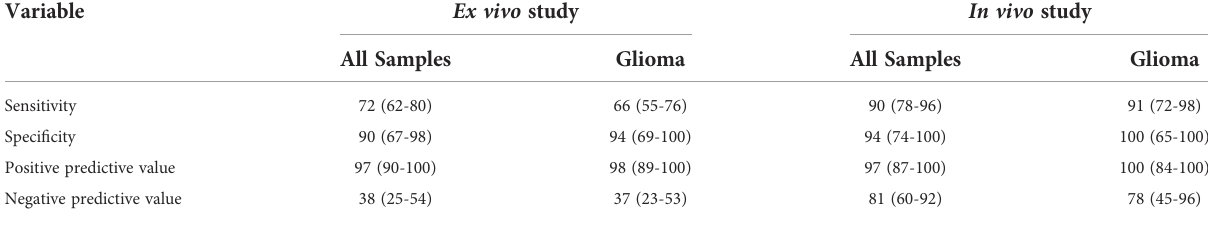
TABLE 2 Diagnostic performance of confocal laser endomicroscopy (CLE) in all cases and glioma